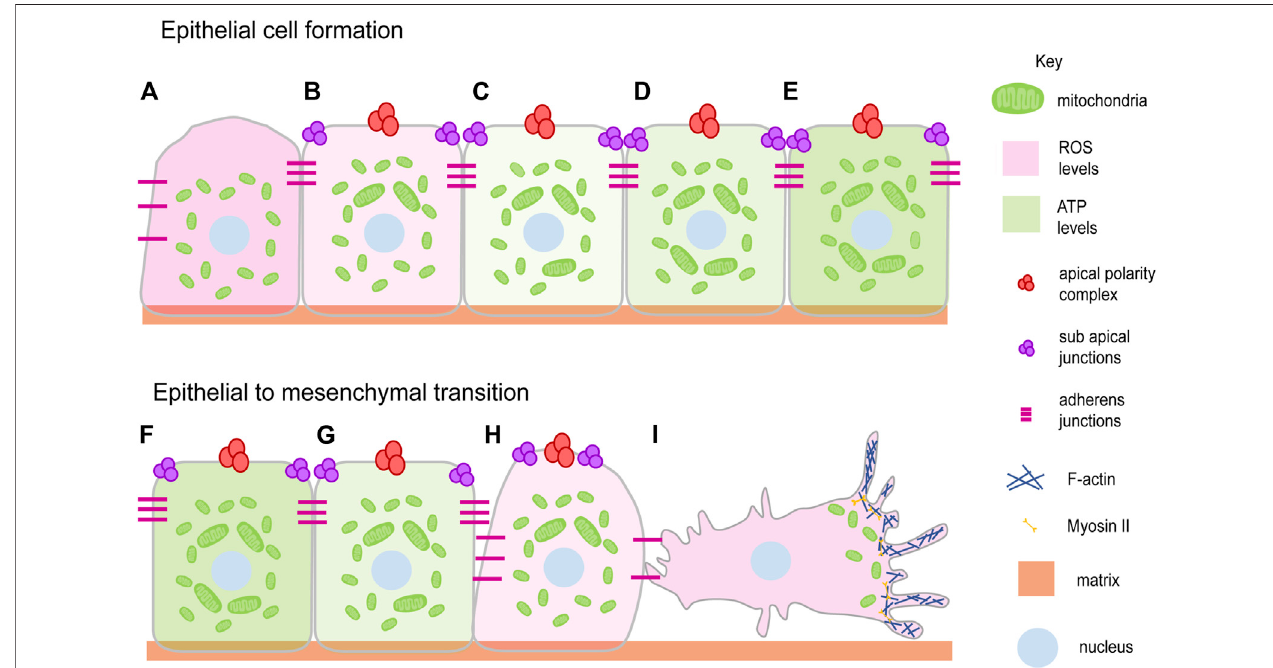
FIGURE 1 | Mitochondrial dynamics and epithelial architecture. Mitochondria transit from spherical to elongated shape during progressive epithelial cell formation andmaturation(Fuetal.,2013;DaoThietal.,2020) (A – E) .Thisoccursover6 – 7 dayswhenlivercellpolarizationisallowedtooccur invitro .Epithelialpolarityislostduring epithelialtomesenchymaltransitionduringseveralprocessessuchascellmigration,woundclosureanddiseaseprogressionwiththechangeinthemitochondrialshape fromelongatedtospherical (G – I) .EMTbringsthemigratoryabilitytothecellbydetachingandlosingpolaritycomplexes(Denisenkoetal.,2019;Leeetal.,2019) (I) . Mitochondria elongate and show an increase in ATP generating ability (light green gradient) during epithelial cell formation (B – E) and become fragmented showing a decrease in ATP generating ability during EMT (Lee et al., 2019) (F – I) . The ROS levels decrease (light pink gradient) during epithelial cell formation (A – E) and increase during EMT (Zhang et al., 2020; Liu et al., 2020) (F – I) . Mitochondria (Green), Apical polarity complexes (Red), Sub apical junctions (Purple), Adherens junctions (Pink), Matrix (Light orange), Nucleus (Light